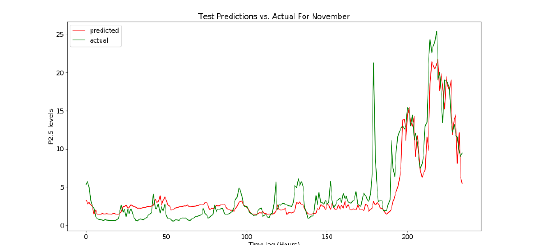
Figure 8. Prediction vs Actual PM 2.5 values using